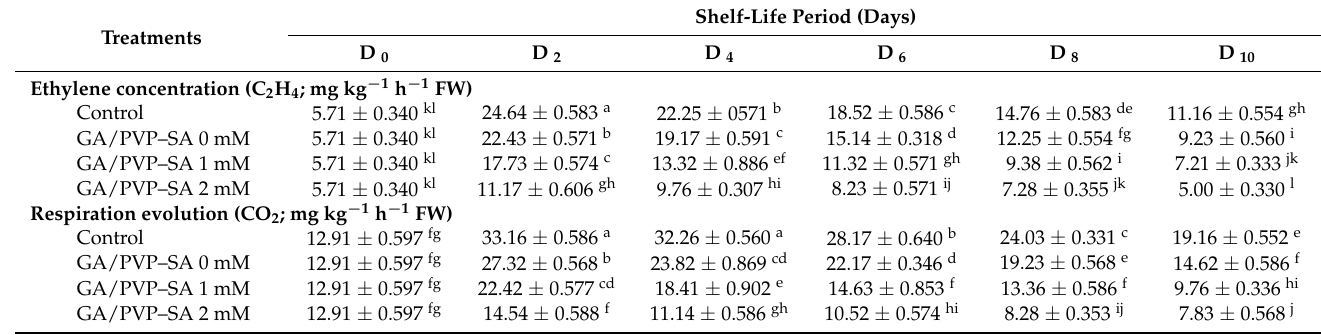
Table 5. Effect of different treatments of gum arabic (GA) and polyvinylpyrrolidone (PVP) blended with salicylic acid (SA) at different concentrations as a mixture biopolymer coating treatment (GA/PVP–SA) on ethylene and respiration production rate of peach fruit ‘Early Sweet’ during shelf life at ambient air (29 ± 1 ◦ C and air humidity 51%) during two seasons (2020 and